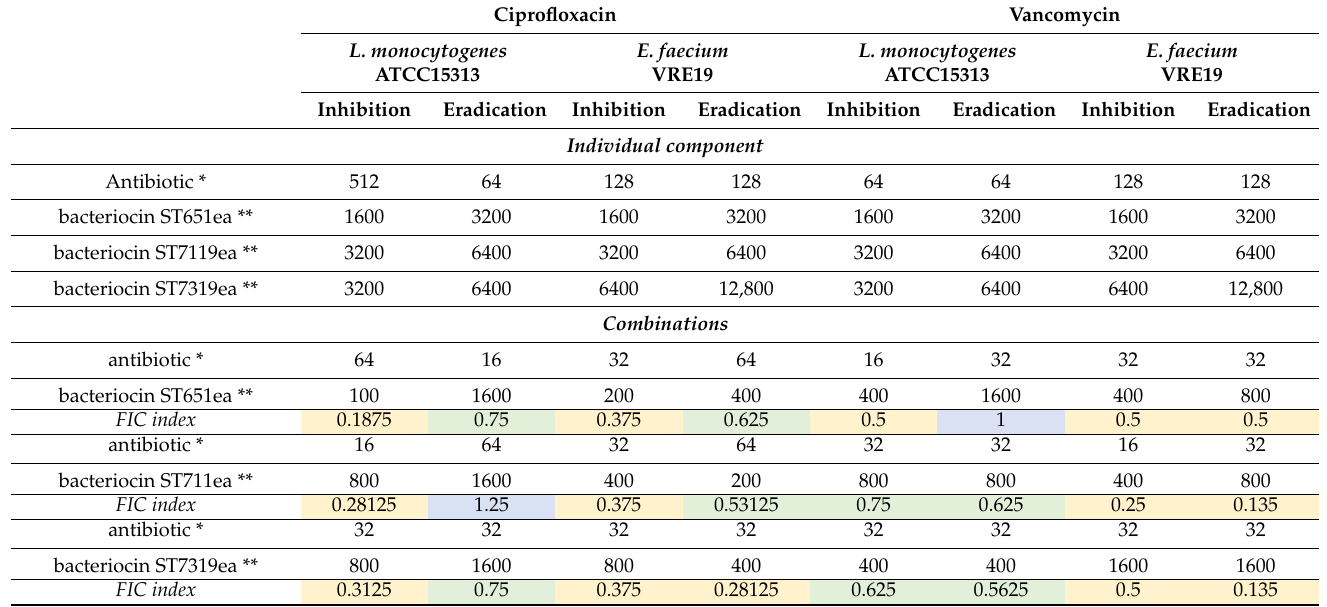
Table 1. The ≤ MIC95 values of ciprofloxacin, vancomycin, and bacteriocins ST651ea, ST7119ea, and ST7319ea and the FIC indices calculated based on two-component antimicrobials